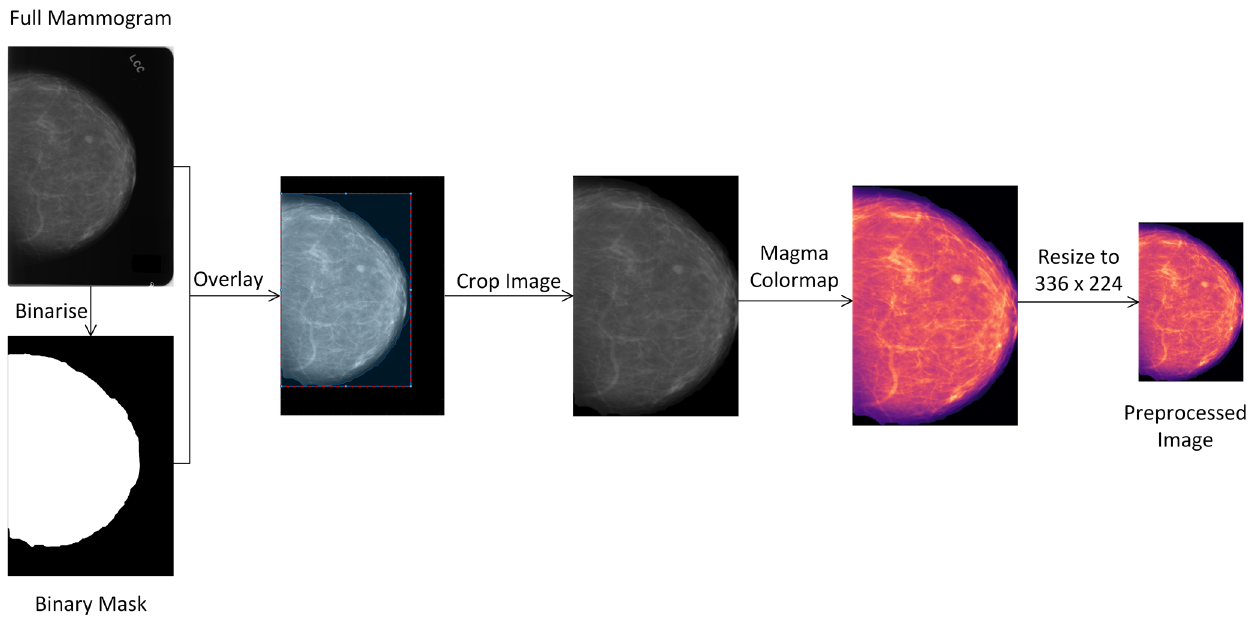
Figure 3. Preprocessing method for mammogram image.